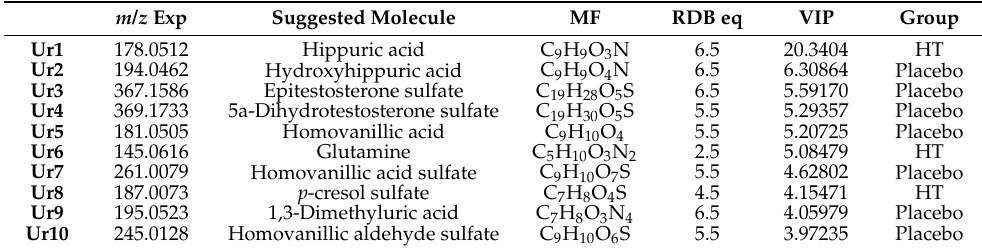
Table 8. Identified statistically significant metabolites from the orthogonal partial least squares– discriminant analysis (OPLS-DA) and S-plot. For each metabolite, a code number was given. The experimental m / z value, the suggested molecule, the molecular formula (MF), the ring and double bond equivalence (RDB eq) and the variable importance of projection value (VIP) are given. In the last column, the group of each metabolite is also noted.